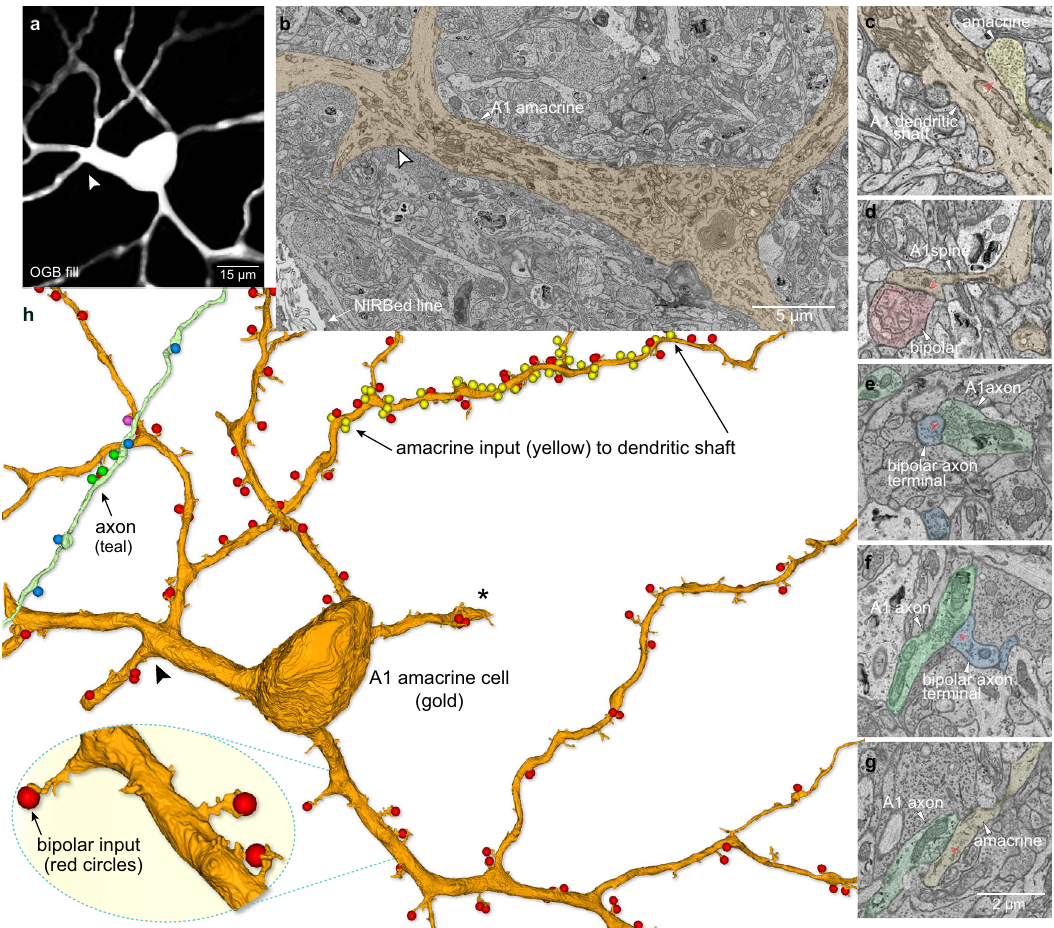
Fig. 5 The spiking ON – OFF A1 cell shows complete polarization of synaptic inputs and outputs. a Proximal dendritic morphology of a physiologically identi fi ed A1 amacrine cell, dye- fi lled (OGB + Alexa 468); 2P-confocal image; arrowhead points to the same dendritic location in a , b , h . b Ultrastructure of primary dendrites of A1 cell (tan fi ll) shown in a, with cell body protruding into the inner plexiform layer (IPL) con fi rms identi fi cation of this cell in EM tissue volume; partial view of NIRBed line at lower left (arrow). c A1 cell dendritic shaft (tan) receiving an inhibitory synapse (yellow, red arrowhead). d A1 cell dendritic spine (tan) receives a ribbon synapse (red arrowhead) from a bipolar-cell axon terminal (pink). e , f A1 cell axon-like process (teal) synapses on a bipolar-cell axon terminal (blue, red arrowheads) at 2 different locations; synapses from bipolar cells to A1 amacrine-cell axon-like processes were not observed. g A1 cell axon-like process synapses (teal, red arrowhead) on an amacrine cell process (yellow). The scale bar applies c – f . h Reconstruction of proximal dendrites and axon segment for A1 cell shown in a , illustrates that synaptic inputs from bipolar-cell ribbon contacts (red balls) were made primarily to the dendritic spines that arose from dendritic shafts (see inset lower left). By contrast, dense inhibitory synaptic inputs from other amacrine cells were made directly upon the dendritic shafts. Location of amacrine inputs to one segment of a secondary dendrite (between arrows) is indicated by the yellow ball structures. Reconstruction of a segment from the axon-like arbor (teal process at upper left) reveals synaptic output from varicosities primarily to bipolar-cell axon terminals (blue balls) but also to amacrine-cell processes (green balls) and to a ganglion cell dendrite (magenta ball). See also Supplementary Fig.